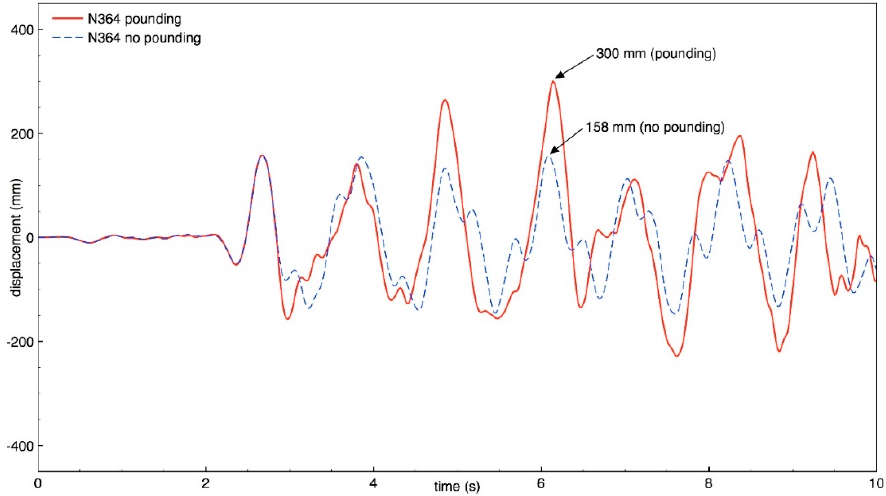
Figure 18. Transverse response of building A (node N360) with and without pounding.